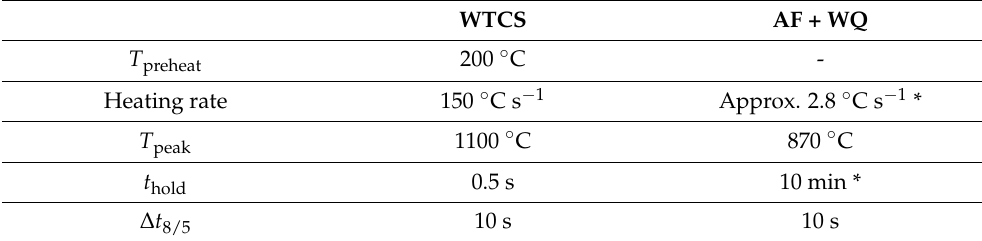
Table 3. Thermal cycles of the simulated